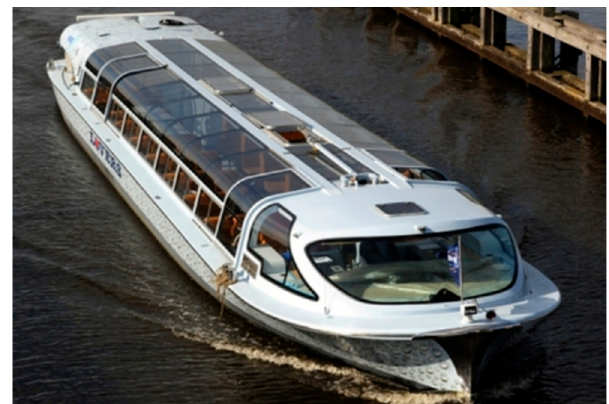
Figure 20. The canal cruise ship “Nemo H2” [104].